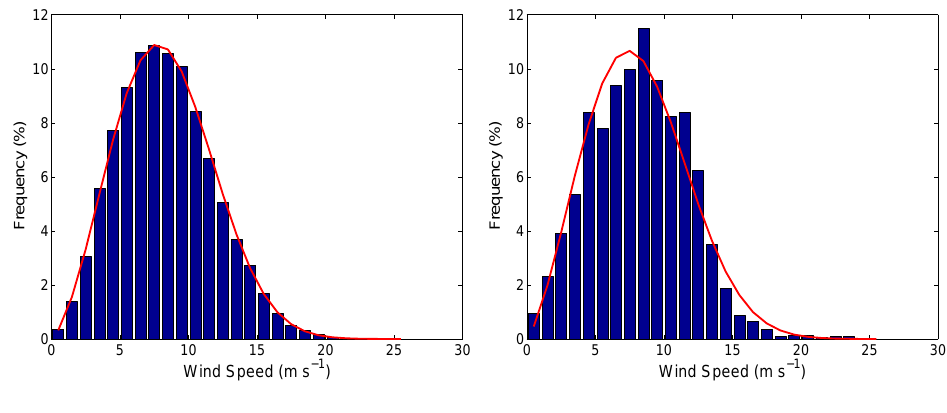
Figure 4. Comparison of the observed (left panel) and the WRF-NCAR model forecast-derived (right panel) wind speed probability density functions at Sweetwater, TX (100 m AGL). The red lines denote the fitted Weibull probability density functions. Study period: April, 2006–March,